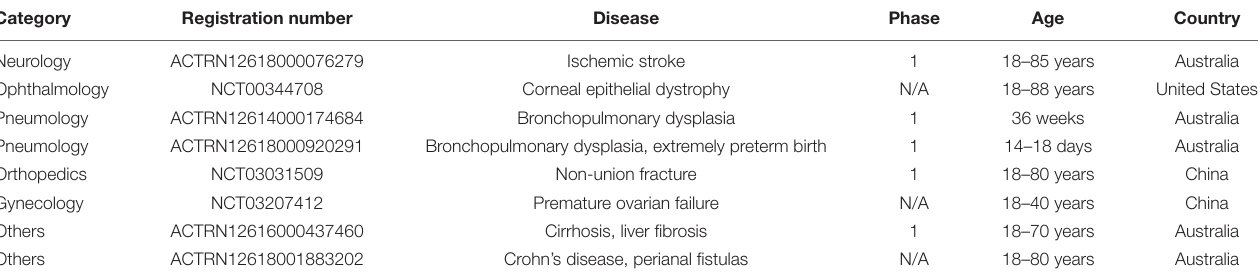
TABLE 1 | Completed and active clinical trials utilizing hAECs to treat immune-related